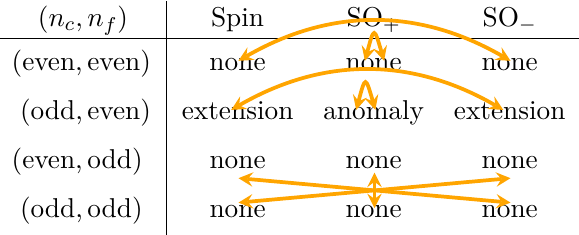
Table 2 . How the Z 2 1-form symmetry and the SO(2 n f ) / Z 2 0-form symmetry are combined in massive so (2 n ) QCD. Our conventions follow that of table c